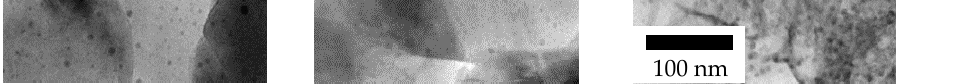
Figure 4. TEM images of ( A ) Ag(56)-Na(1)/CaCO 3 , ( B ) Ag(56)-Na(1)/SrCO 3 and ( C ) Ag(56)-Na(1)/MgCO 3. The scale of these figures is the same.